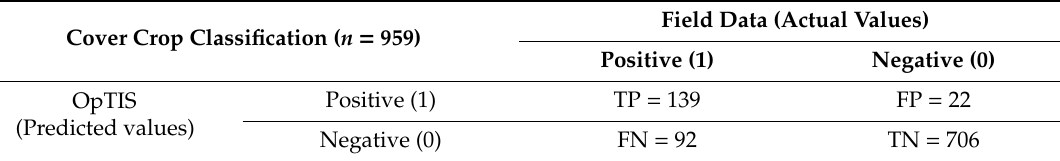
Table 3. Confusion matrix of cover crop classification by remote sensing (predicted values) vs. reference field data (actual values). Green cells indicate the number of fields with agreeing cover crop classification, termed true-negative TN and true-positive TP. White cells indicate the number of fields with disagreeing classification, termed false-negative FN and false-positive FP.